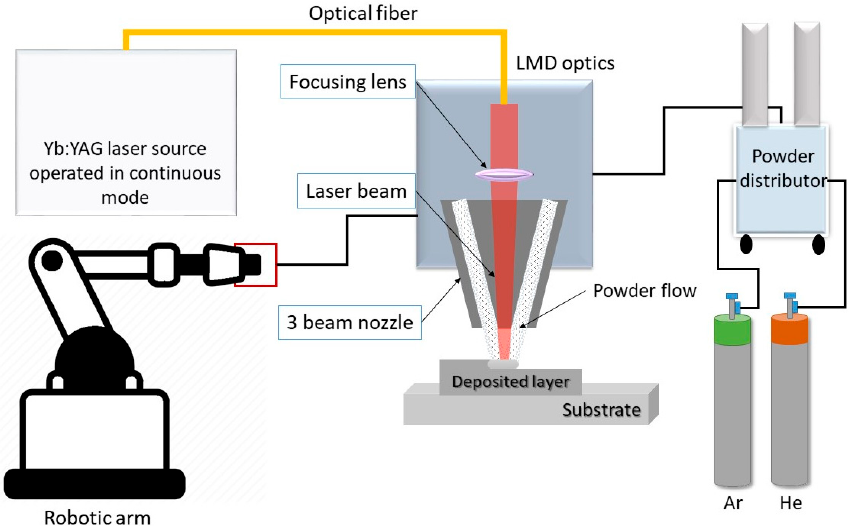
Figure 1. Schematic representation of the LMD system used in our experiments.